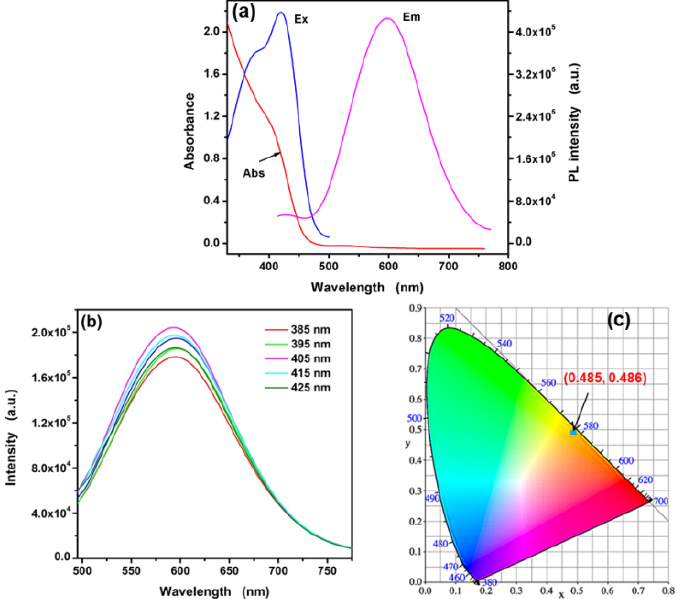
Figure 5. ( a ) UV-visible absorption (red line), emission spectrum (pink line), excitation spectrum (blue line), and ( b ) excitation-related emission spectra of L-Asp@CdS QDs, and ( c ) CIE 1931